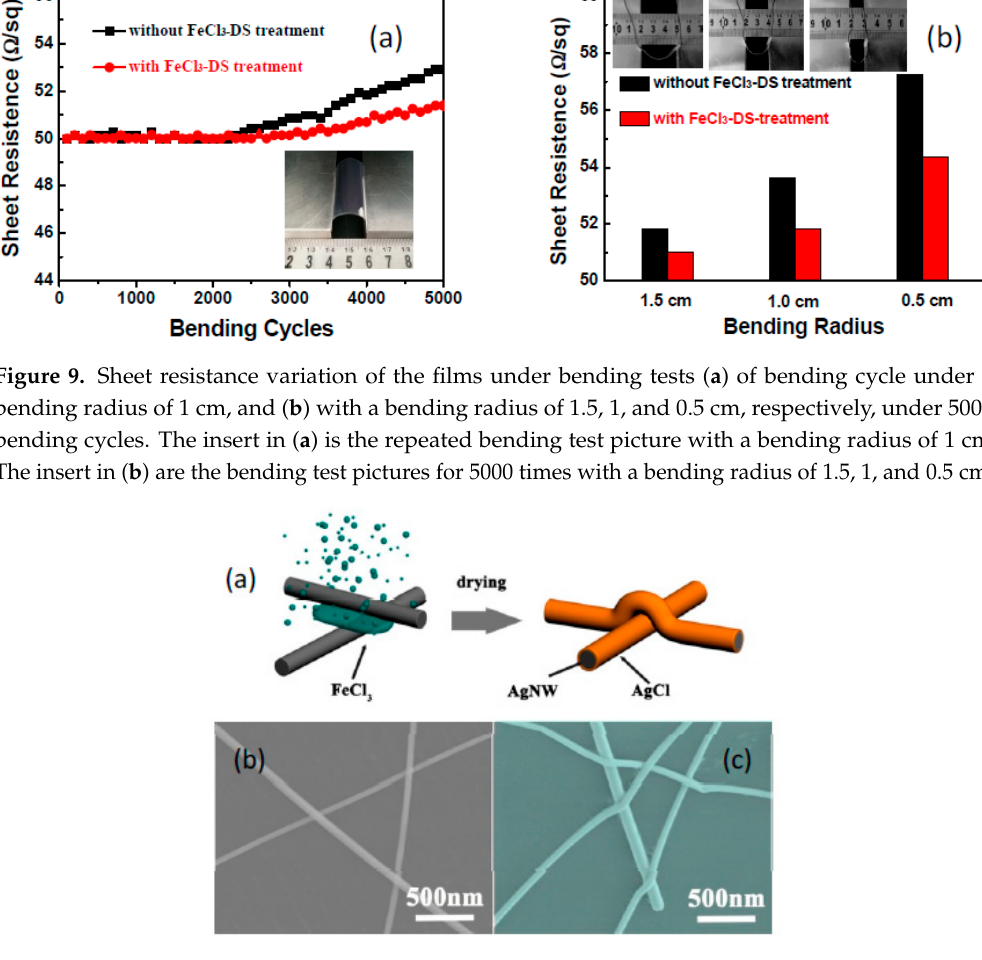
Figure 10. ( a ) Schematic display of FeCl 3 -DS treatment for capillary-force-induced welding of AgNWs and AgCl layer mediated tightening between AgNWs and the substrate as well as among AgNW themselves. SEM images of ( b ) pristine and ( c ) FeCl 3 -DS treated AgNW TCFs. Overall, the FeCl 3 -DS treatment not only improves the conductivity and stability of AgNW TCFs, but also enhances their mechanical flexibility.